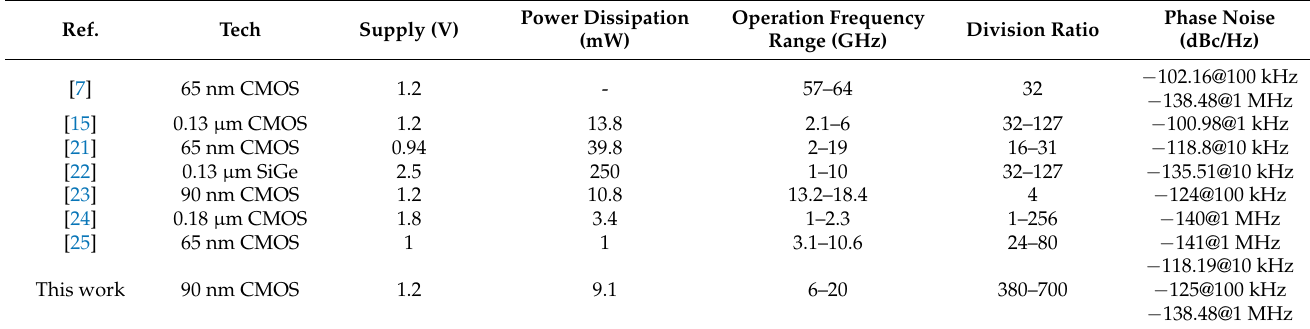
Table 1. Performance summary and comparison to other